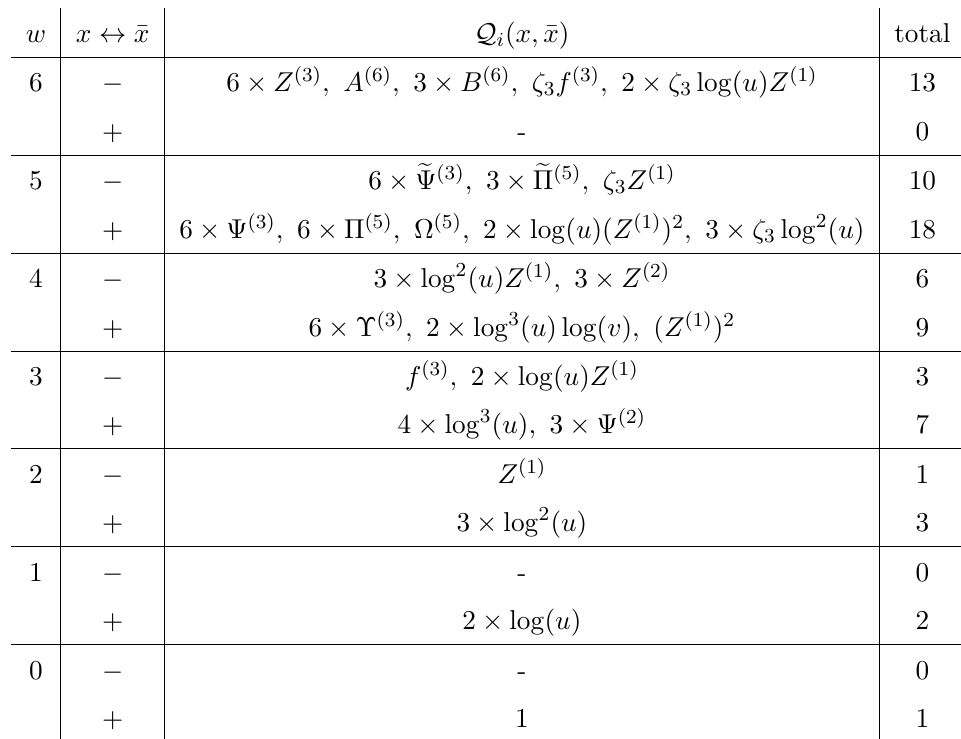
Table 1 . Overview of the basis of transcendental functions Q , ordered by their transcendental weight w . At each weight, we classify the basis elements according to their symmetry under x ↔ ¯ x exchange, distinguishing antisymmetric ( − ) from symmetric ( + ) functions. The third column explicitly lists the functions Q ( x, ¯ x ) together with their number of independent orientations under crossing (e.g. i at weight w = 1 , the entry 2 × log( u ) means there exist 2 orientations of this basis element, given by log( u ) and log( v ) in this case). Finally, in the last column we give the total number of functions in each